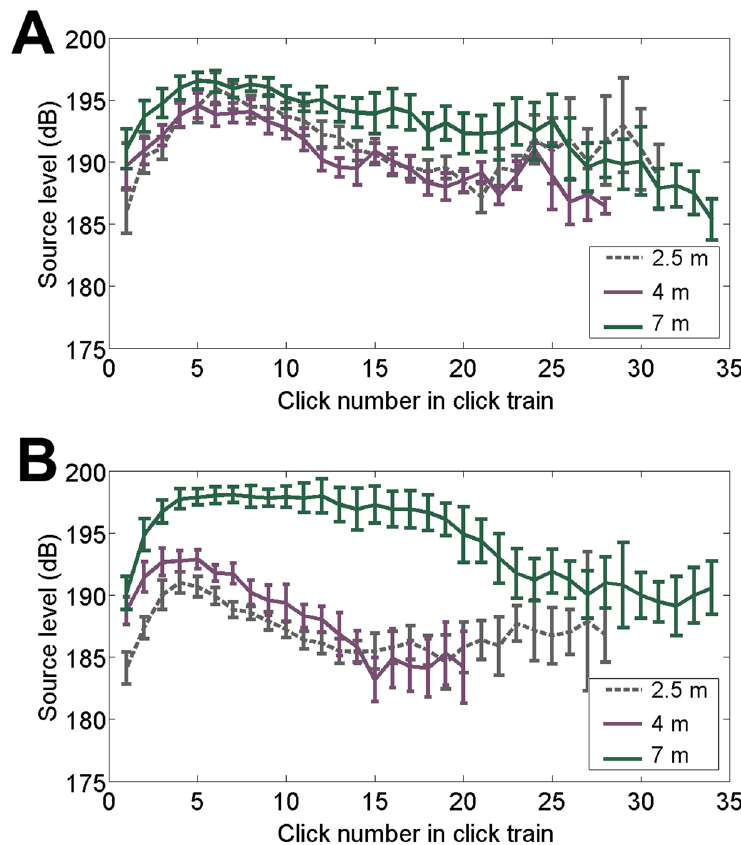
Figure 3. Change in source levels throughout trials according to target distance and condition. Click source levels (mean and standard error) as a function of click number for 2.5, 4 and 7 m target distance for the unpredictable targets (3a, top) and predictable targets (3b, bottom). Clicks within a trial were indexed by click number and then the values of each click number were averaged across all trials. Source levels were calculated from the peak-to-peak voltage and are reported in dB re: 1 m Pa. Because some click numbers towards the end of the click train consisted of less than 5 values, we only further analyzed click numbers at the end of the click trains that had 5 or more values. See Table 1 for the number of clicks that make up each data point.